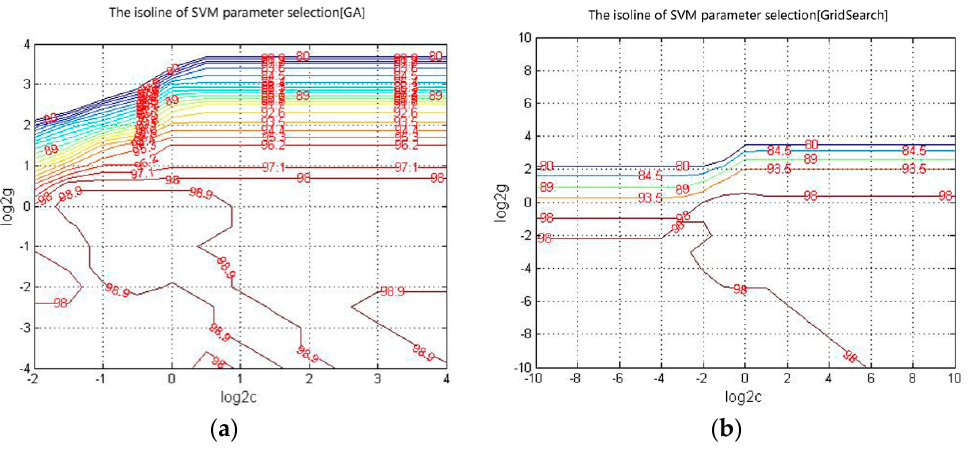
Figure 8. ( a ) The isolines of GA-SVM; and ( b ) Grid Search-SVM parameter selection.